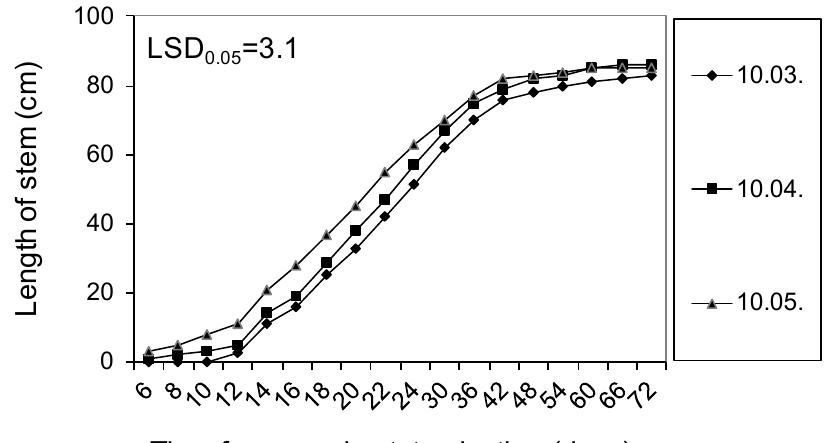
Figure 4. Growth kinetics of Impresja potato stems obtained from seed potatoes stored at 4 °C from harvest until 10 February of the following year and then at 15 °C and 80% RH until planting in the soil on 10 March, 10 April, and 10 May. LSD was calculated at the significance level of p = 0.05. The inoculation of phytopathogens ( Fusarium oxysporum , Pectobacterium carotovorum , and Rhizoctonia solani ) to seed potatoes on 10 February had a varied effect on plant develop- ment, depending on the time elapsed from pathogen inoculation to plant emergence and also on sprouting stage during the planting of mother tubers into the soil. During planting in plant microcosms, the seed potatoes and the sprouts showed neither mechanical damage nor visible symptoms of disease infestation. Stems, obtained from the seed potatoes inoc- ulated with phytopathogens, developed slightly slower than in control variants